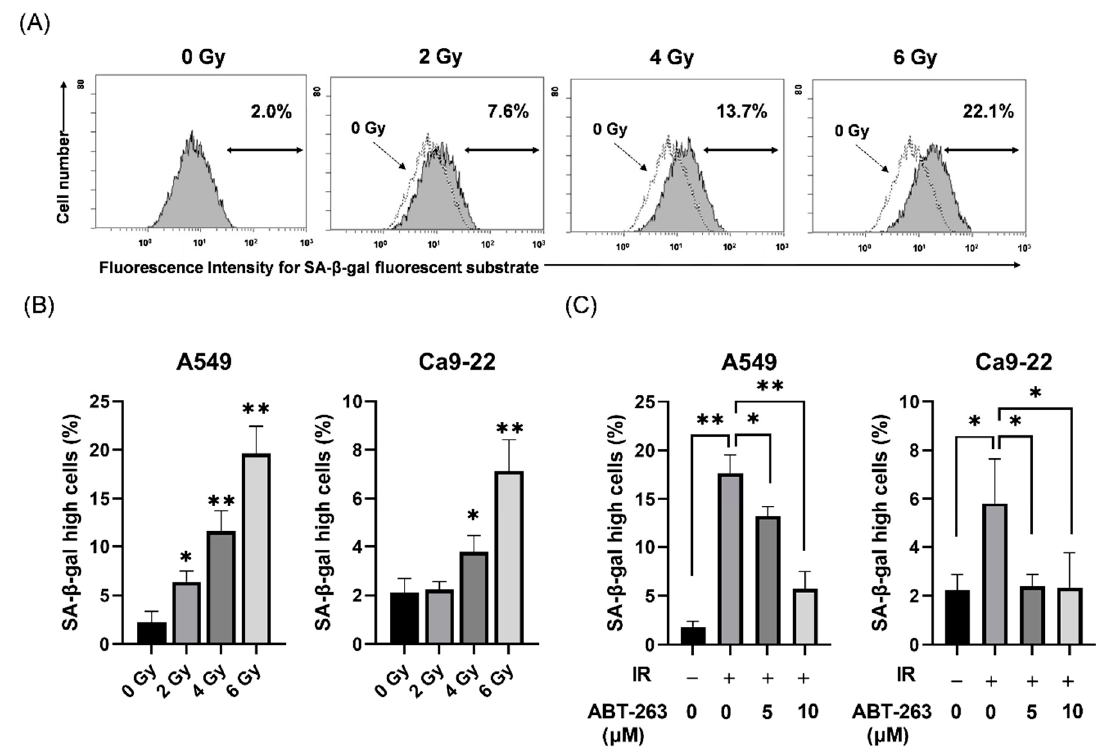
Figure 1. Effect of ABT-263 on populations of SA- β -gal high-activity cells in irradiated cancer cells. ( A ) X-irradiated A549 cells were cultured for 48 h and SA- β -gal activity was analyzed using the Senescence β -Galactosidase Activity Assay Kit. Representative histograms of SA- β -gal activity in A549 cells are shown. The dotted line shows the results of non-irradiated cells and the inset numbers show the percentage of SA- β -gal high-activity cells. ( B ) X-irradiated A549 and Ca9-22 cells were cultured for 48 h prior to analysis of SA- β -gal activity. The results are shown as the percentage of SA- β -gal high-activity cells. ( C ) A549 and Ca9-22 cells irradiated at 6 Gy were cultured for 24 h prior to the addition of ABT-263 to the culture. After culturing (48 h for A549 and 24 h for Ca9-22), SA- β -gal activity was analyzed. The results are shown as the percentage of cell with high SA- β -gal activity. Data are presented as the mean ± standard deviation (SD) of independent experiments. * p < 0.05, ** p < 0.01.